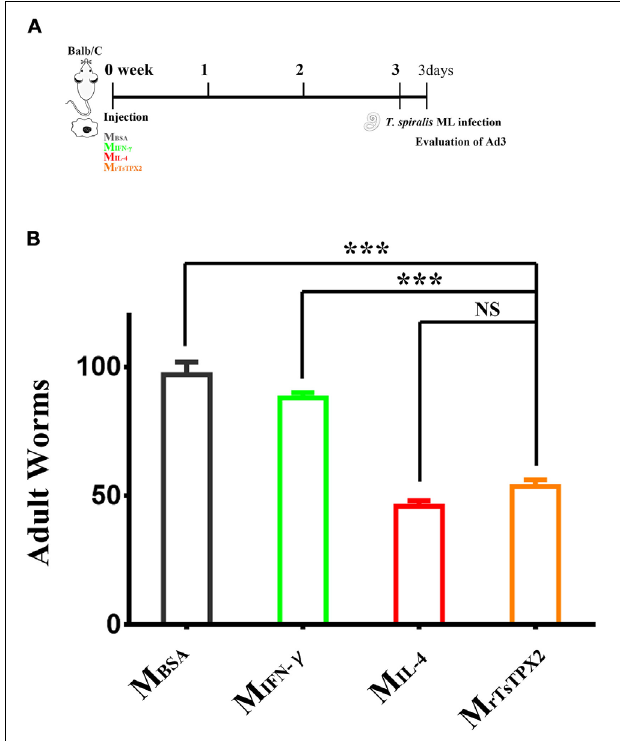
FIGURE 6 | Numbers of 3-day adults from the macrophages transferred mice. (A) Schematics of immune responses in mice adoptively transferred with one of the macrophage types. Three weeks after the first injection, the immunological status was analyzed, and mice were experimentally infected with 500 T. spiralis ML. Analysis of adult load at 3 days after infection. (B) Adult load in the intestine of mice. Experimental groups include mice transferred with macrophages activation by IL-4 as M2 positive control (M IL − 4 ), INF- γ as M1 positive control (M INF − γ ), BSA as mock control (M BSA ) or rTsTPX2 (M rTsTPX2 ). Statistical analysis was performed with Student’s t -test, and data presented are mean ± SDs (representative of three experiments). *** P < 0.001, NS: not significant. n > = 3 mice per